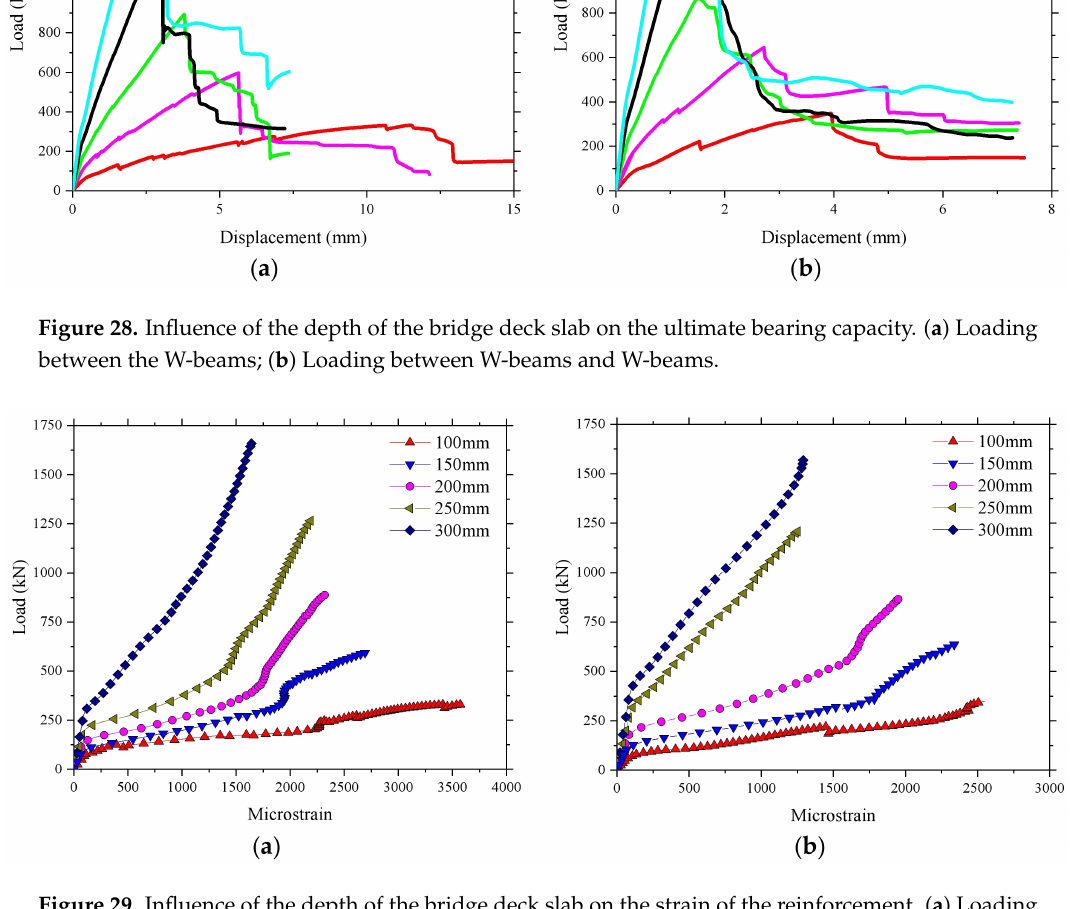
Figure 29. Influence of the depth of the bridge deck slab on the strain of the reinforcement. ( a ) Loading between the W-beams; ( b ) Loading between W-beams and